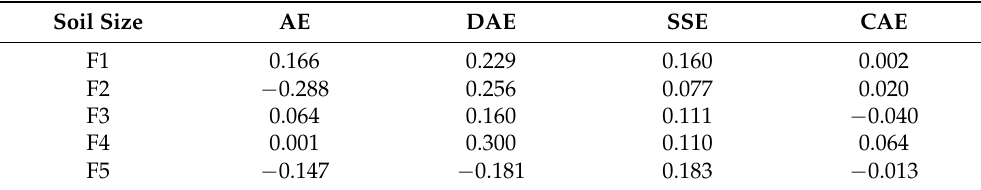
Table 6. Correlation coefficients between the extracted amount of Hg and the Hg content in young leaves (N = 27).